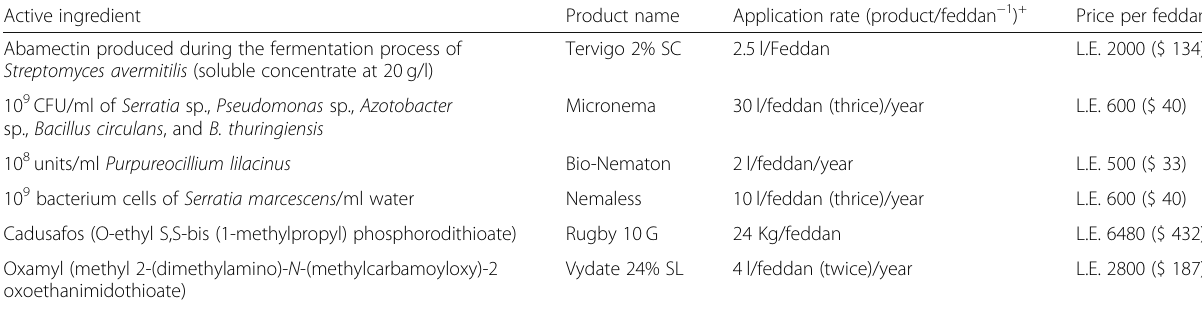
Table 1 Key commercially available bionematicides and chemical nematicides, their applications rates, and prices in Egypt* Active